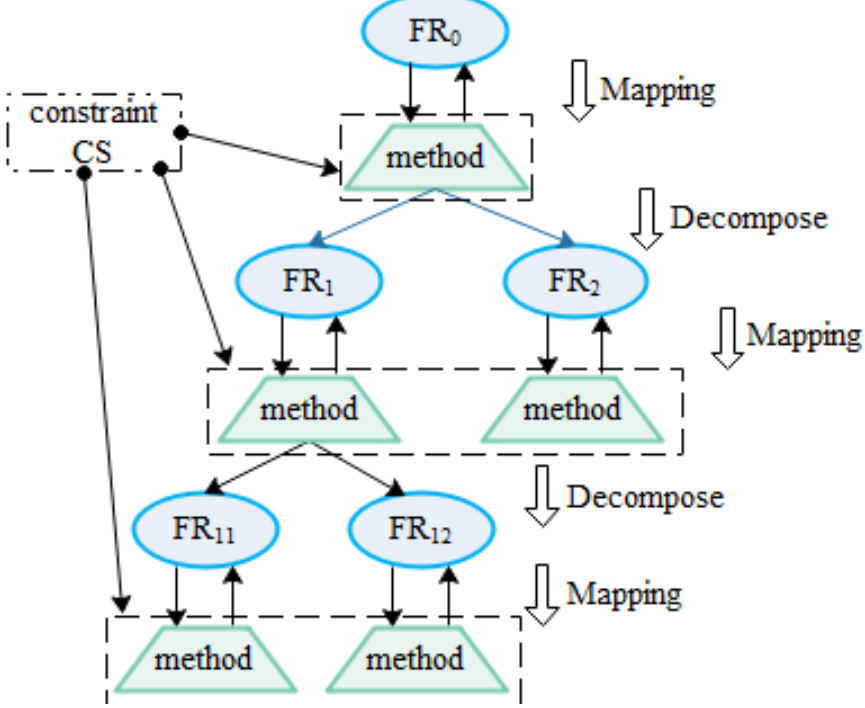
Figure 2. Functional method tree diagram.